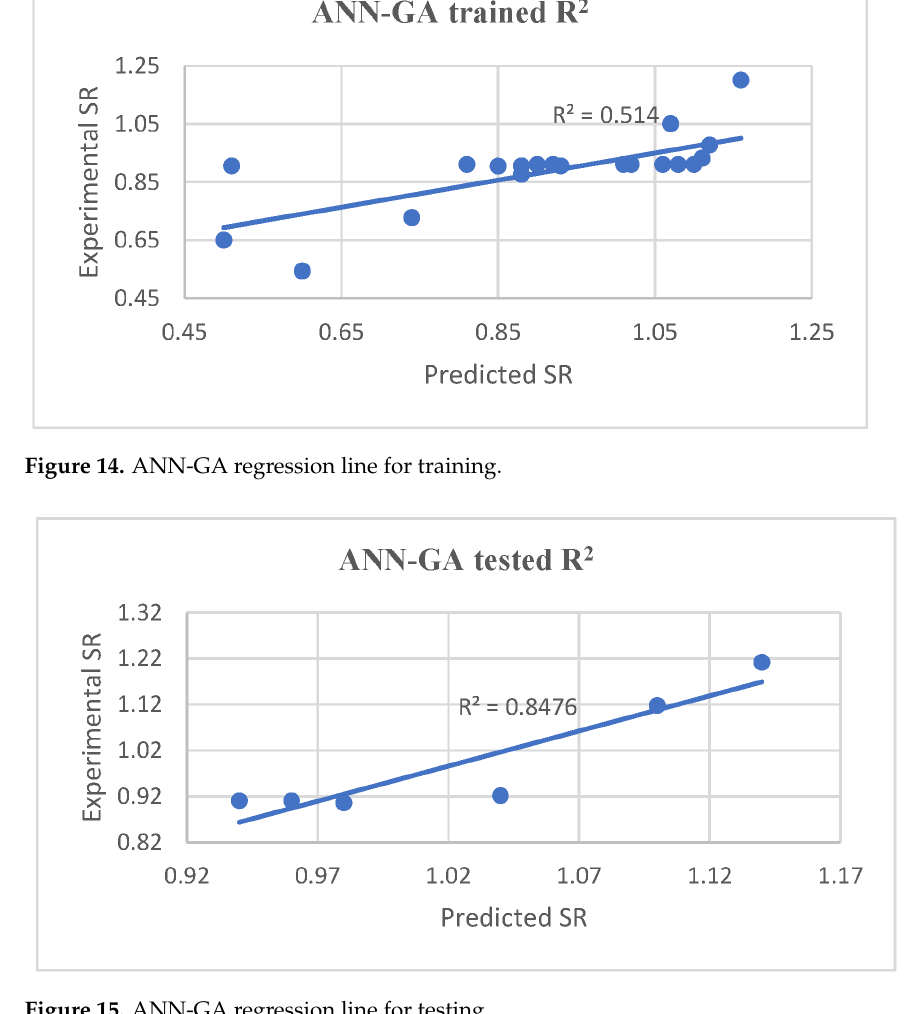
Figure 15. ANN-GA regression line for testing.